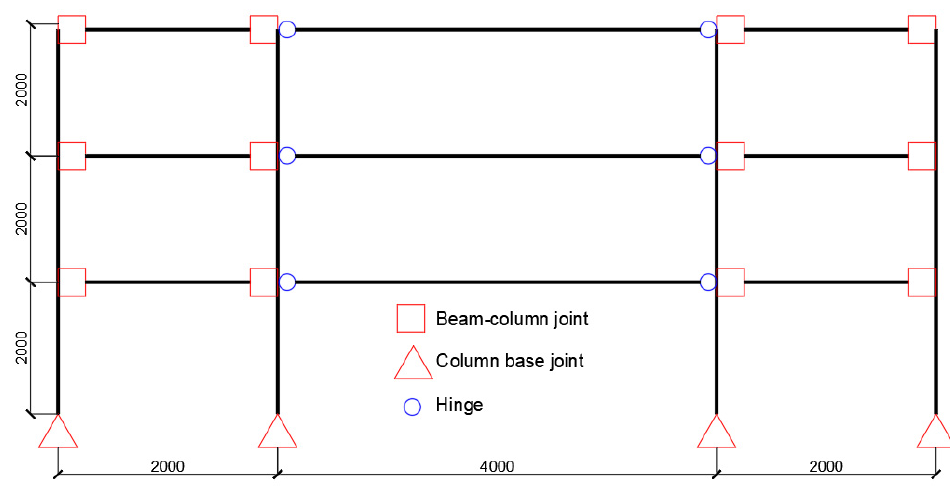
Figure 1. Analysis model for a three-story timber frame house